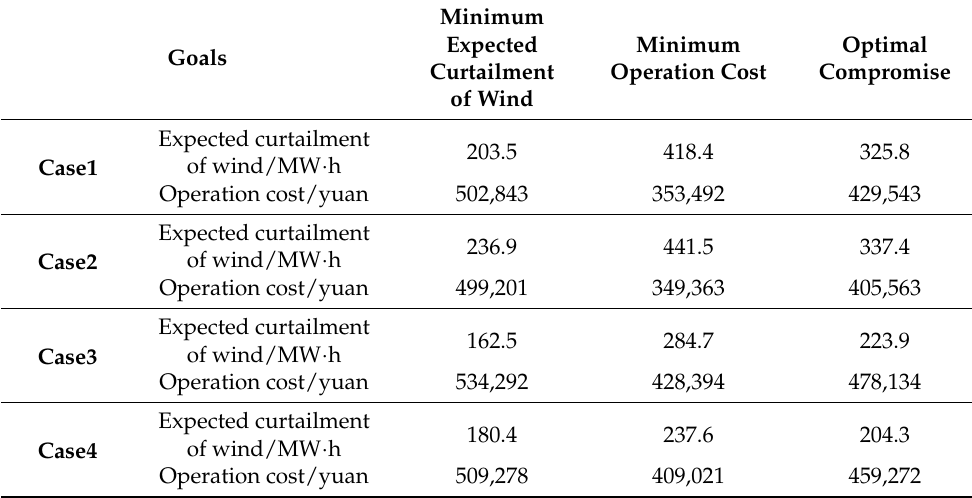
Table 6. Comparison of Pareto optimal solutions in different